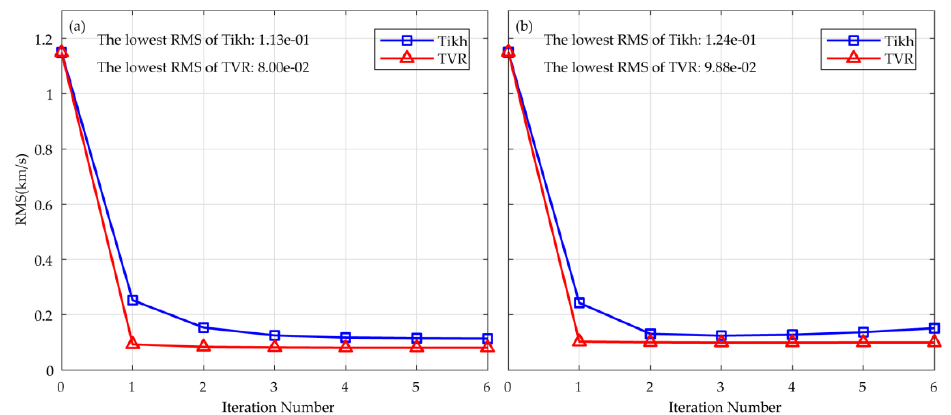
Figure 14. The convergence curve of RMS for velocity solved with correct t cal . ( a ) the dense ray-coverage case; and ( b ) the sparse ray-coverage case. The blue points are the results solved with Tikh, and the red points are the results solved with TVR. The lowest RMS of the results solved by these two methods are both marked in the graph.